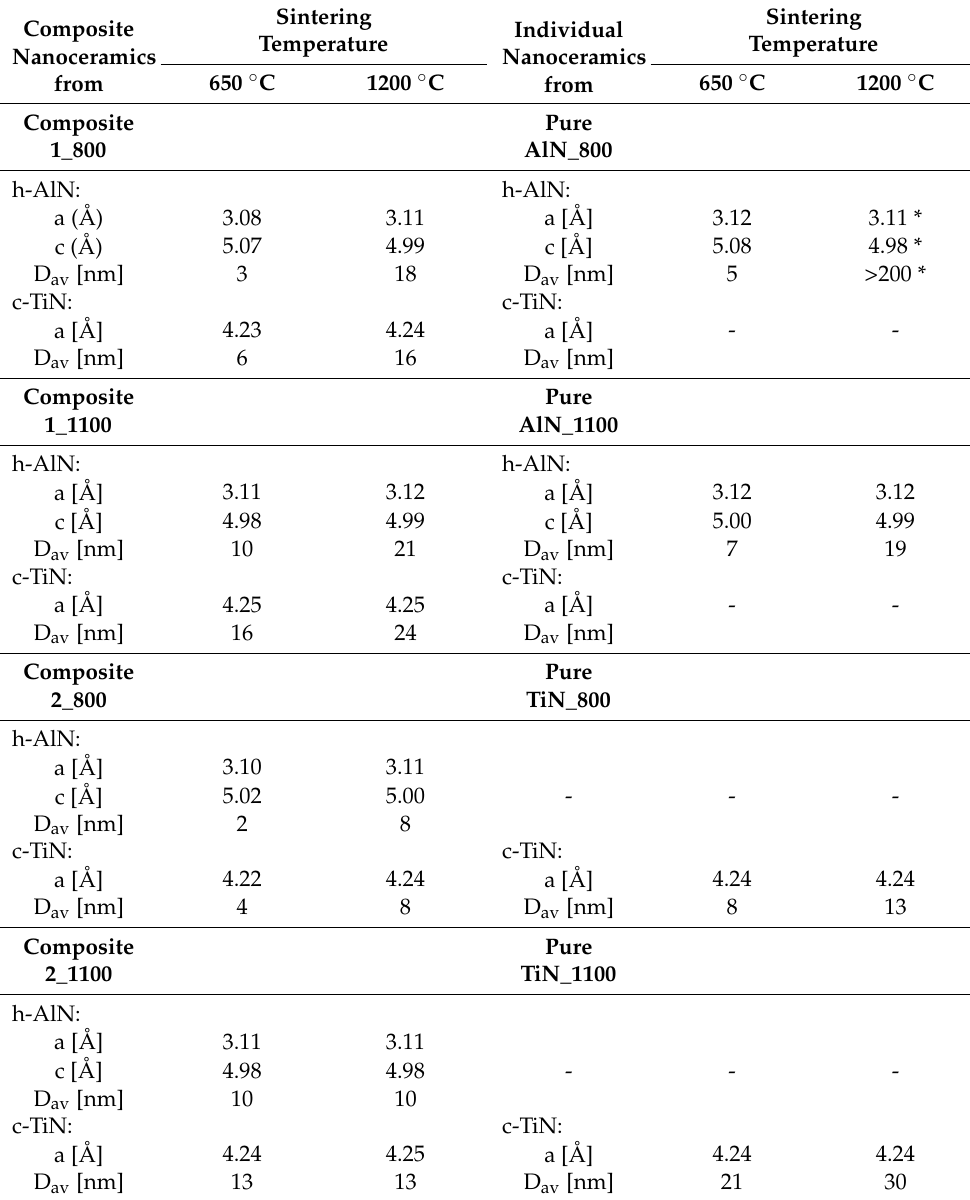
Table 2. XRD-derived crystallographic cell parameters a and c and average crystallite sizes D av ’s determined for composite and individual nanoceramics sintered at 650 and 1200 ◦ C, 7.7 GPa in the system TiN-AlN. * Nanoceramics of partially oxidized AlN powder from 800 ◦ C-nitridation and 1200 ◦